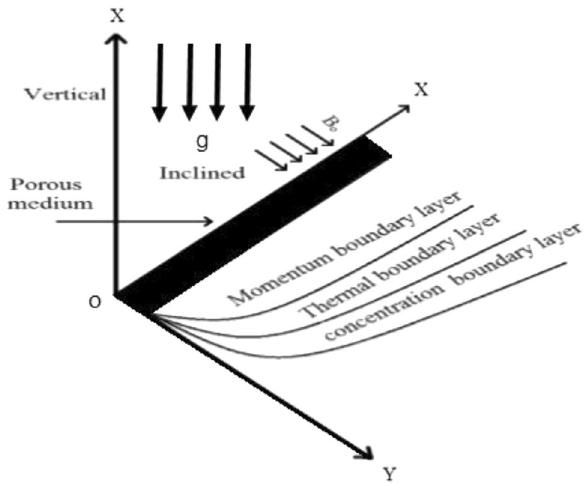
Figure 1. Geometry of the